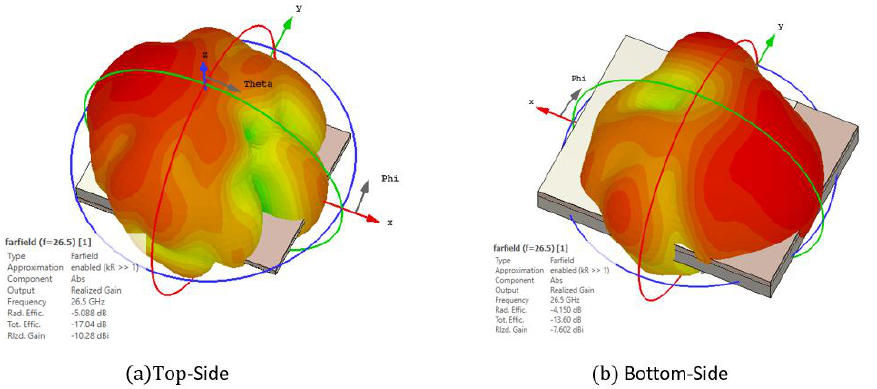
Figure 7. Simulated radiation leakage for the nominal case for both ( a ) TS and ( b ) BS